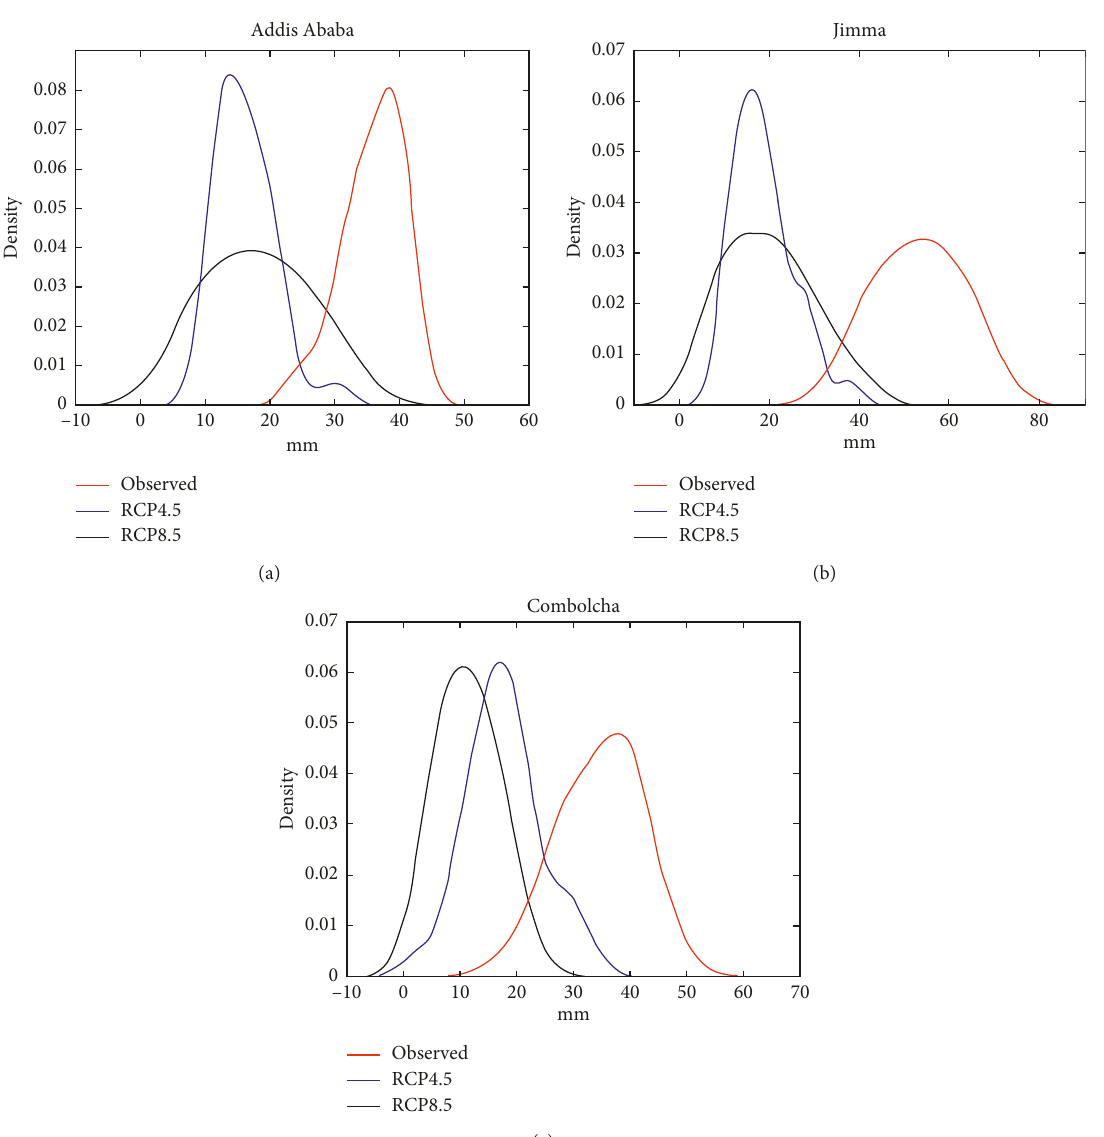
Figure 8: Comparison plot of R10 between observed and projected precipitation extremes under RCP4.5 and RCP8.5